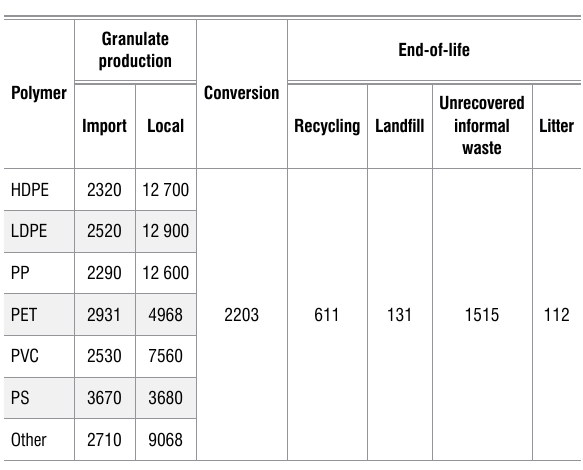
Emission factors per polymer for each lifecycle stage